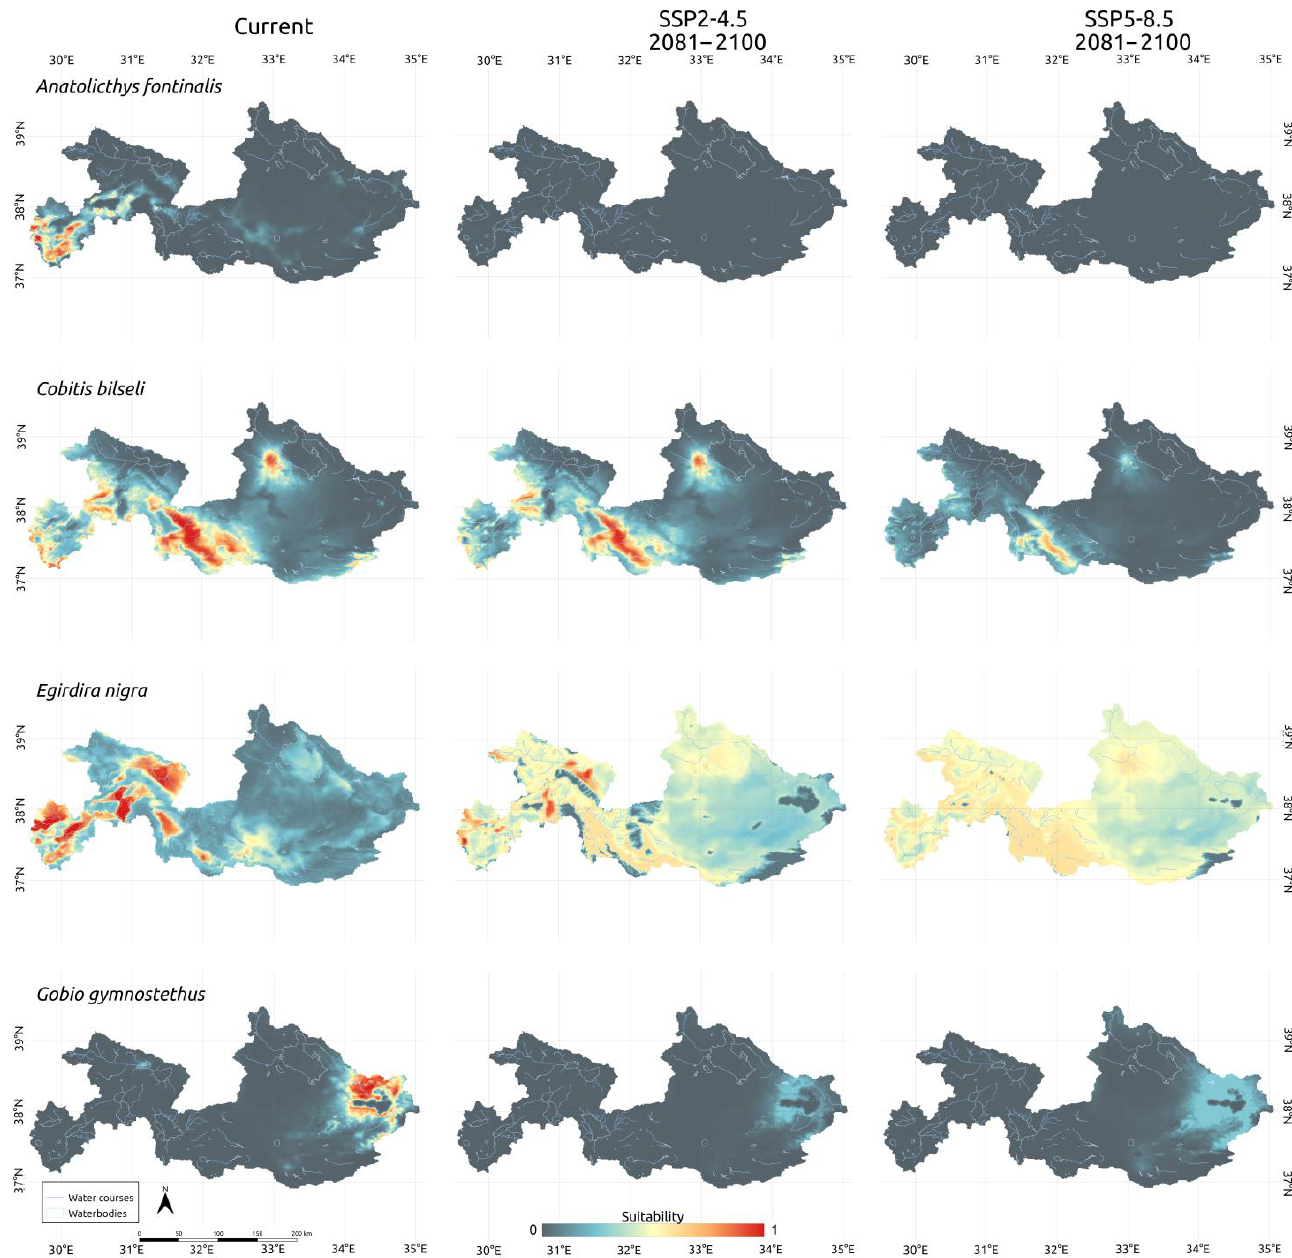
Figure 2. Current and future distribution of Anatolichthys anatoliae , Cobitis bilseli , Egirdira nigra , and Gobio gymnostethus in the CAE. Colours show habitat suitability, and the value of suitability increases in red areas.